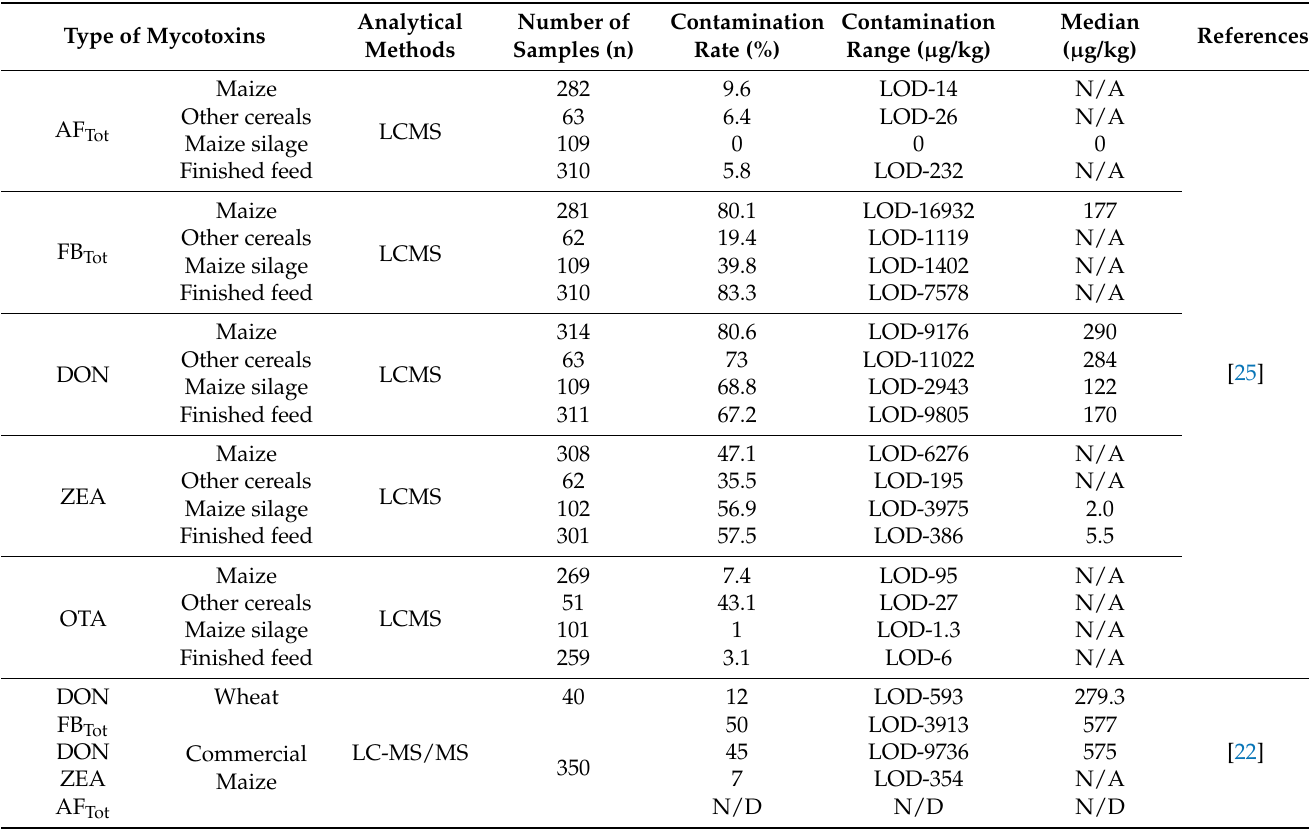
Table 2. Mycotoxin contamination of maize from commercial